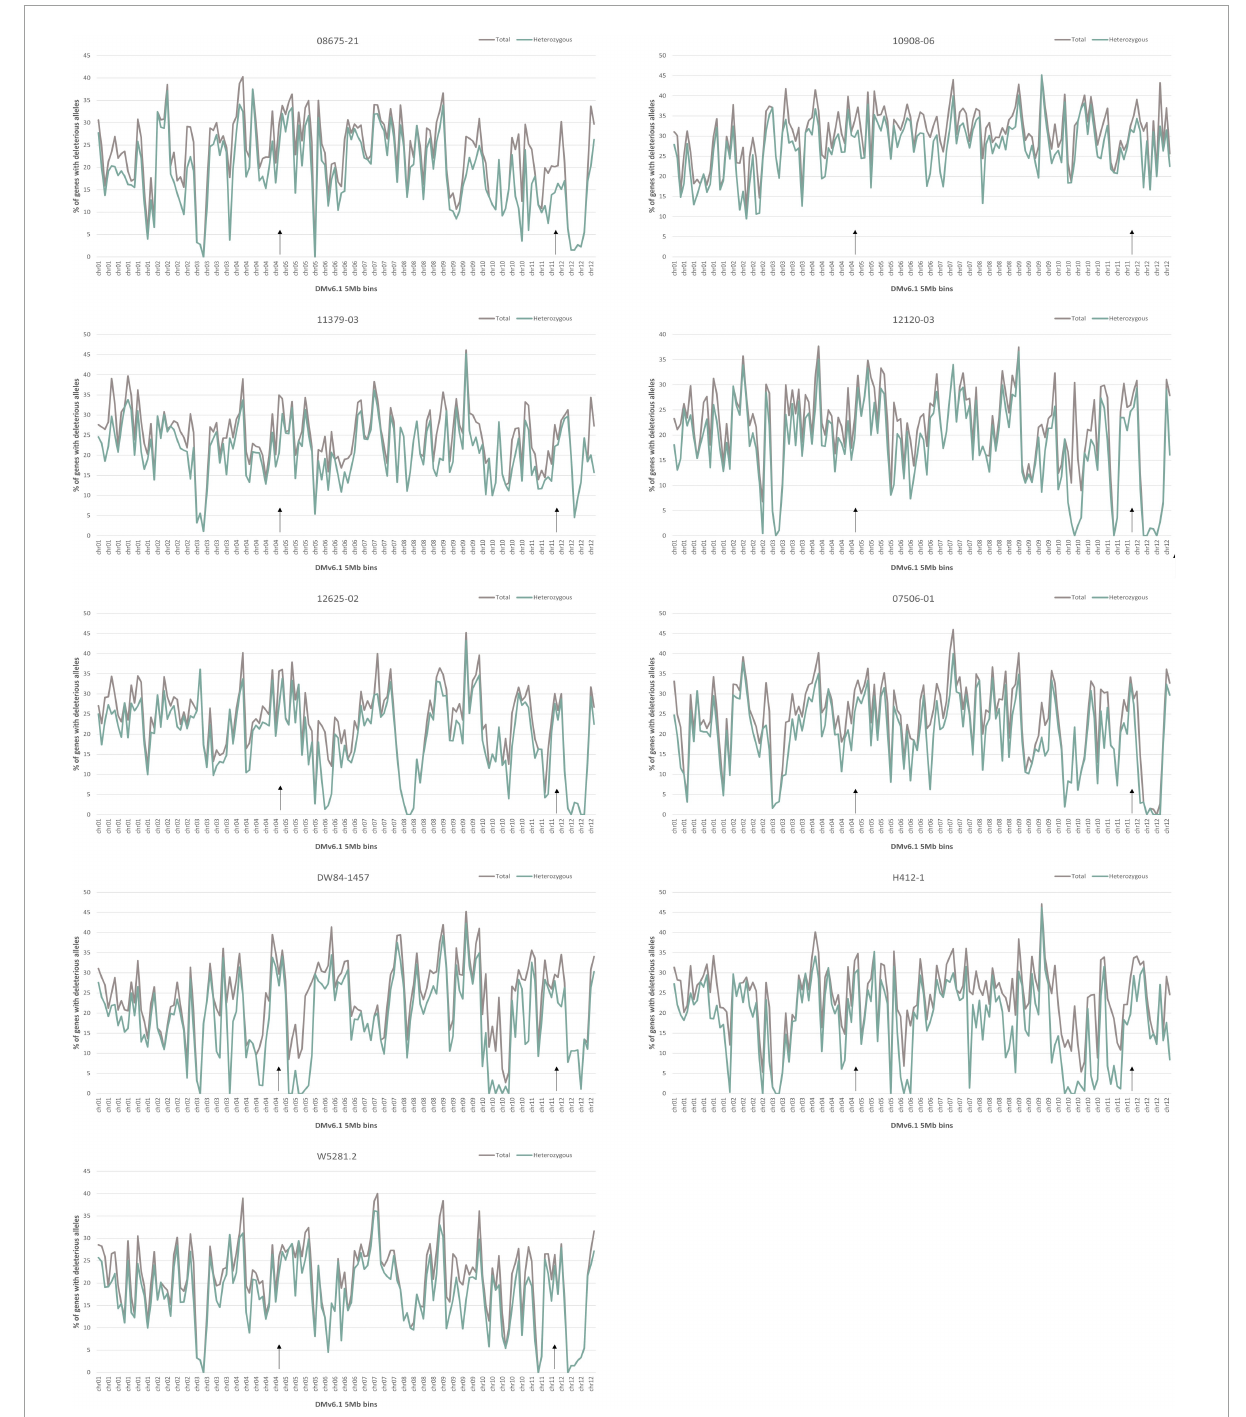
FIGURE5 Percentage of deleterious allele affected genes in 5 Mb bins of DMv6.1 in each genome. Black arrows over the x -axis indicate locations of the genes StCDF1 on chr05 and Sli on chr12.